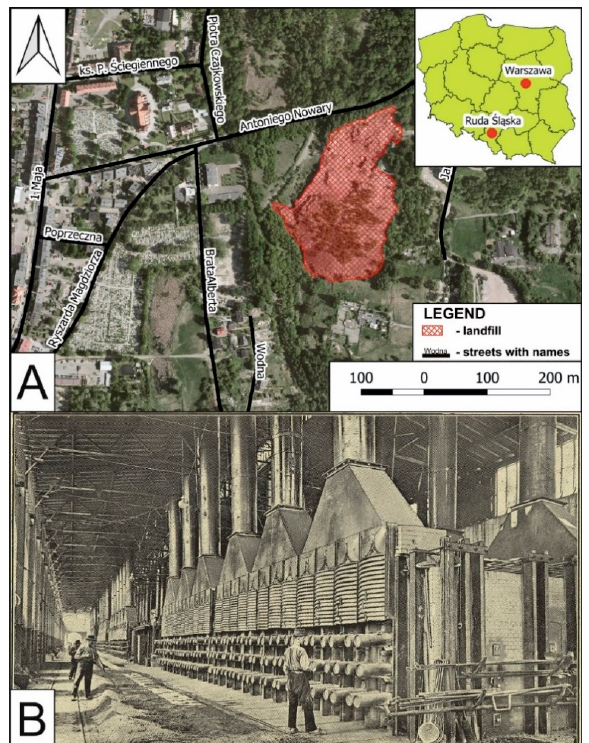
Figure 1. ( A ) Location map of the landfill in Ruda ´Sl ˛aska (based on data from geoportal.gov.pl [40]); ( B ) image showing a Silesian method smelting furnace from the Upper Silesia region